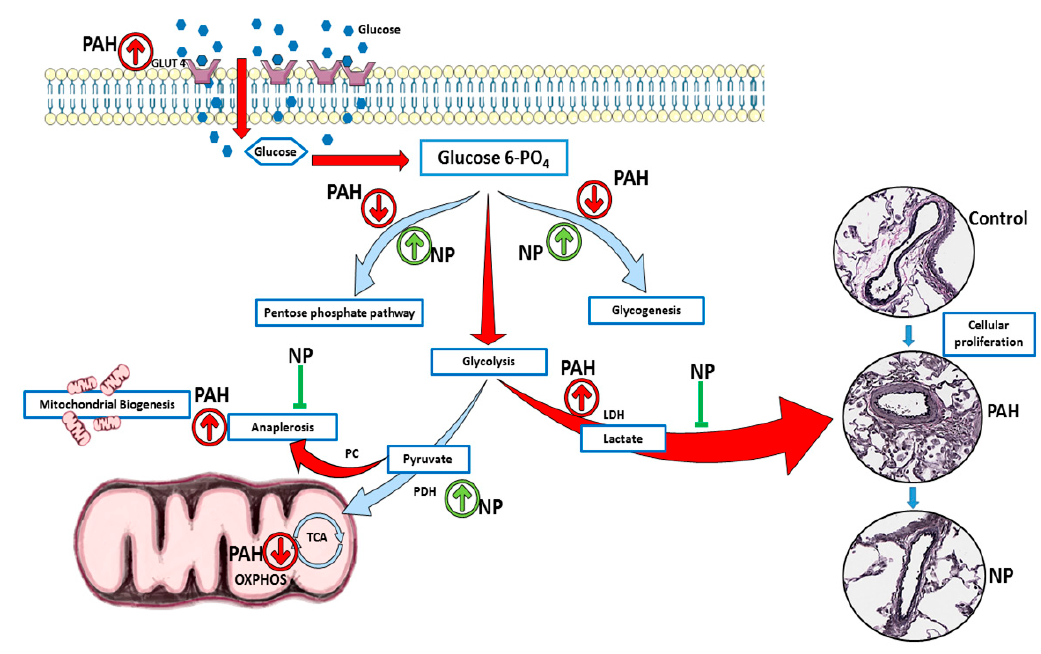
Figure 7. NP attenuated metabolic reprogramming in pulmonary hypertension. In two weeks of sugen / hypoxia, increased nitration induced activation of Akt upregulated the glucose transporter Glut4 to the membrane, and this augmented cellular glucose influx. This results in increased aerobic glycolysis and anaplerosis as well as a reduction in glycogenesis and pentose phosphate pathway. These metabolic derangements result in increased cellular proliferation and vascular remodeling in lung tissue of early PAH. NP treatment balanced cellular glucose influx, glycogen synthesis, and the pentose phosphate pathway. NP corrected the glycolytic shift, improved oxidative phosphorylation, and inhibited anaplerotic reprogramming. Thus, proliferative pathological changes in PAH were found to be prevented with NP treatment. PAH, pulmonary arterial hypertension; NP, nitroxide-conjugated peptide; TCA, tricarboxylic acid cycle; OXPHOS, oxidative phosphorylation.